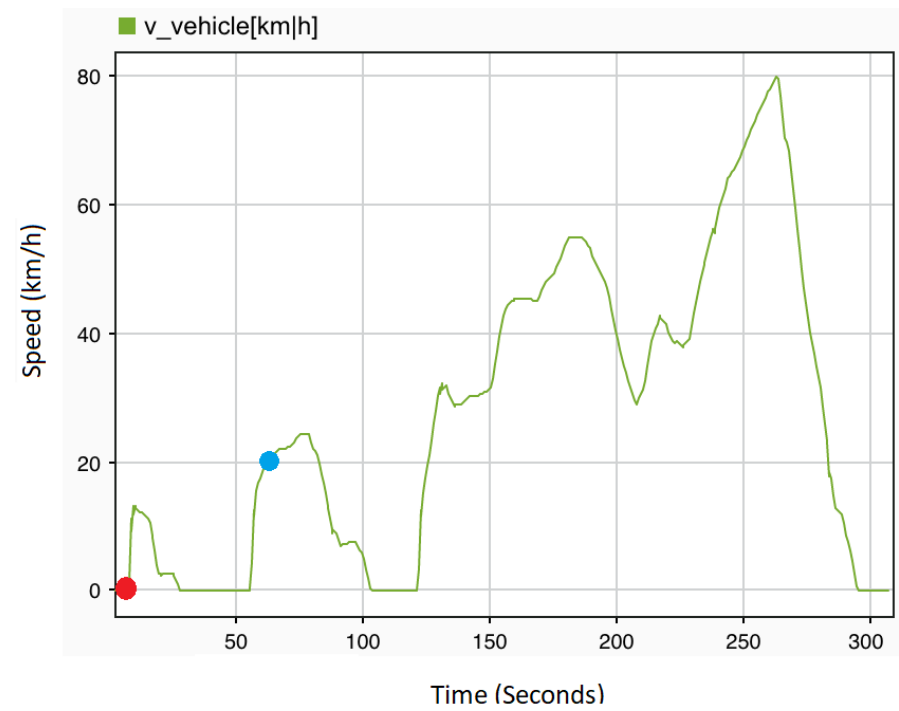
Figure 8. Driving cycle in dSPACE